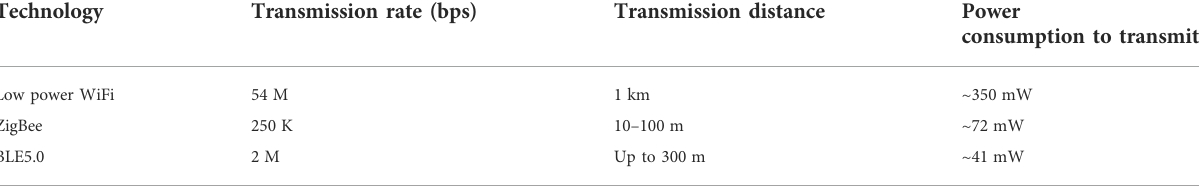
TABLE 3 Comparison of traditional low-power wireless transmission technologies (Tang et al.,